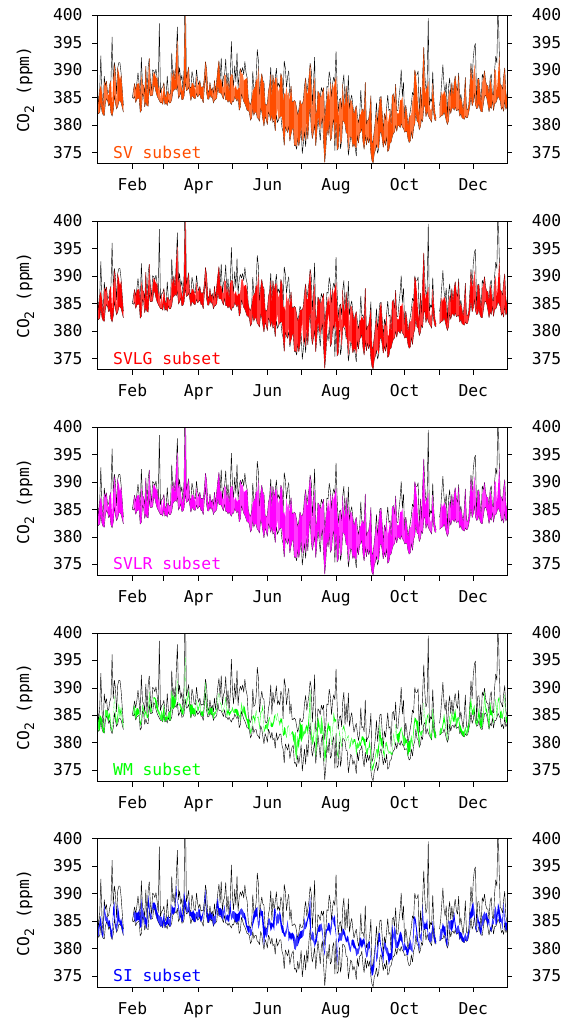
Fig. 3. Diel and seasonal variability in CO 2 mole fractions from all five filters are contrasted against the complete set of observations using one year of data (2006) from one RACCOON site (Storm Peak, Colorado). This figure shows that hourly statistical filters (SV, SVLG, SVLR) retain a majority of the diel variability in CO 2 , while windowing-filters produce subsets with fewer observations constrained to narrower diel